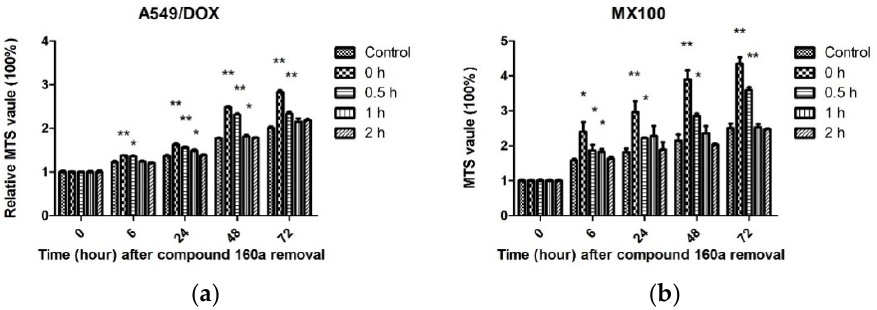
Figure 9. Duration of the MDR reversal e ff ect of compound 160a on doxorubicin in DOX-resistant